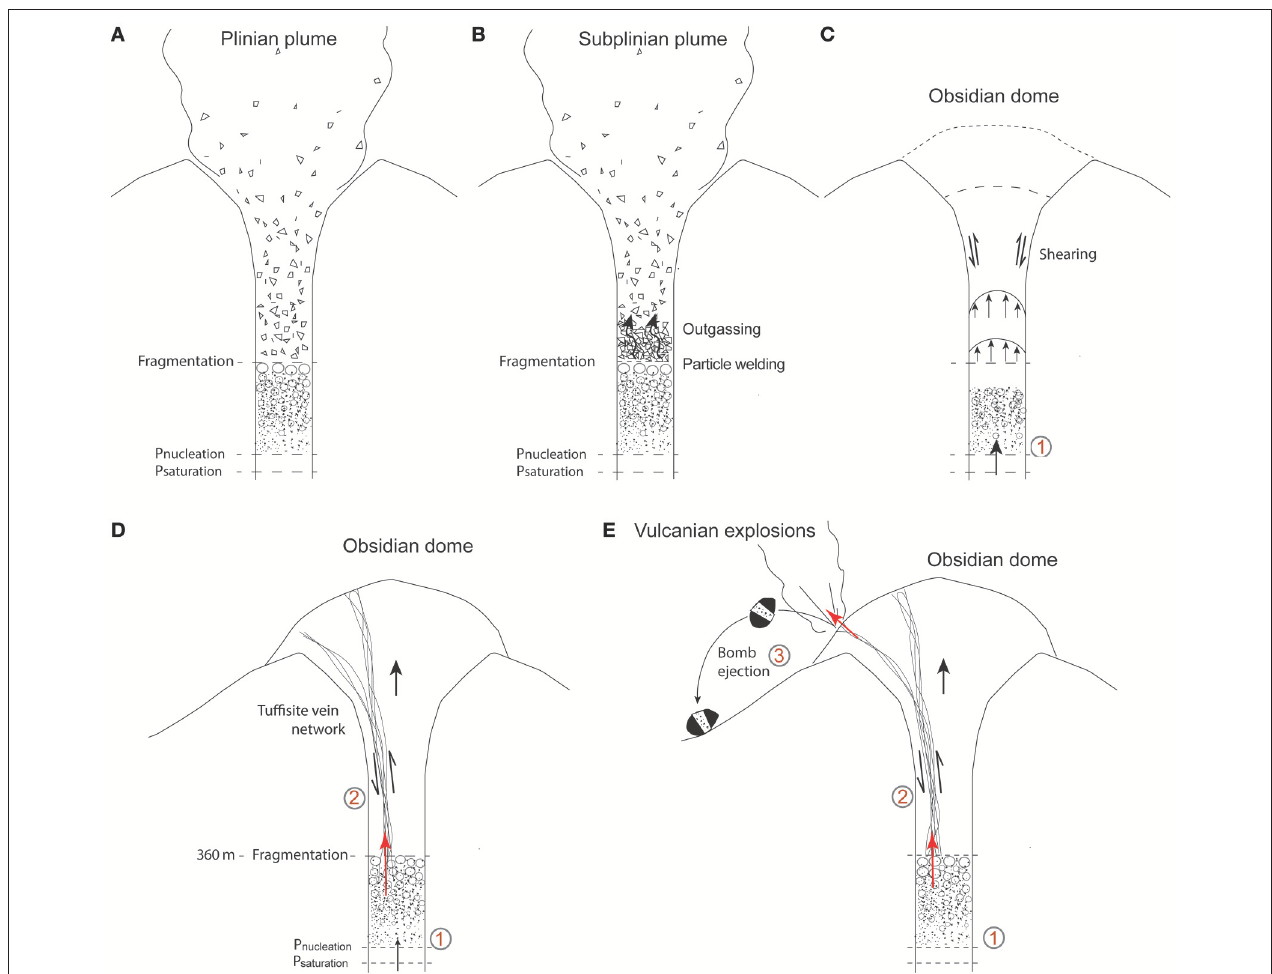
FIGURE 9 | Schematic model of evolving processes in the Chaitén conduit. (A) Initial Plinian eruption, with magmatic foam fragmentation involving a single bubble nucleation step. (B) Progressive particle welding and compaction allow dense plug formation. (C) Magma ascent below the plug still induces a bubble nucleation step (1). The obsidian dome and dense conduit plug is deformed by deeper magma pressure. (D) This leads to plug rupture, with tuffisite veins briefly connecting the deeper and shallower conduit, allowing ascent of deep particles and driving abrupt decompression and bubble nucleation (2). (E) Permeability occlusion drives a final fragmentation event, with bomb ejection and a final decompression-induced nucleation event